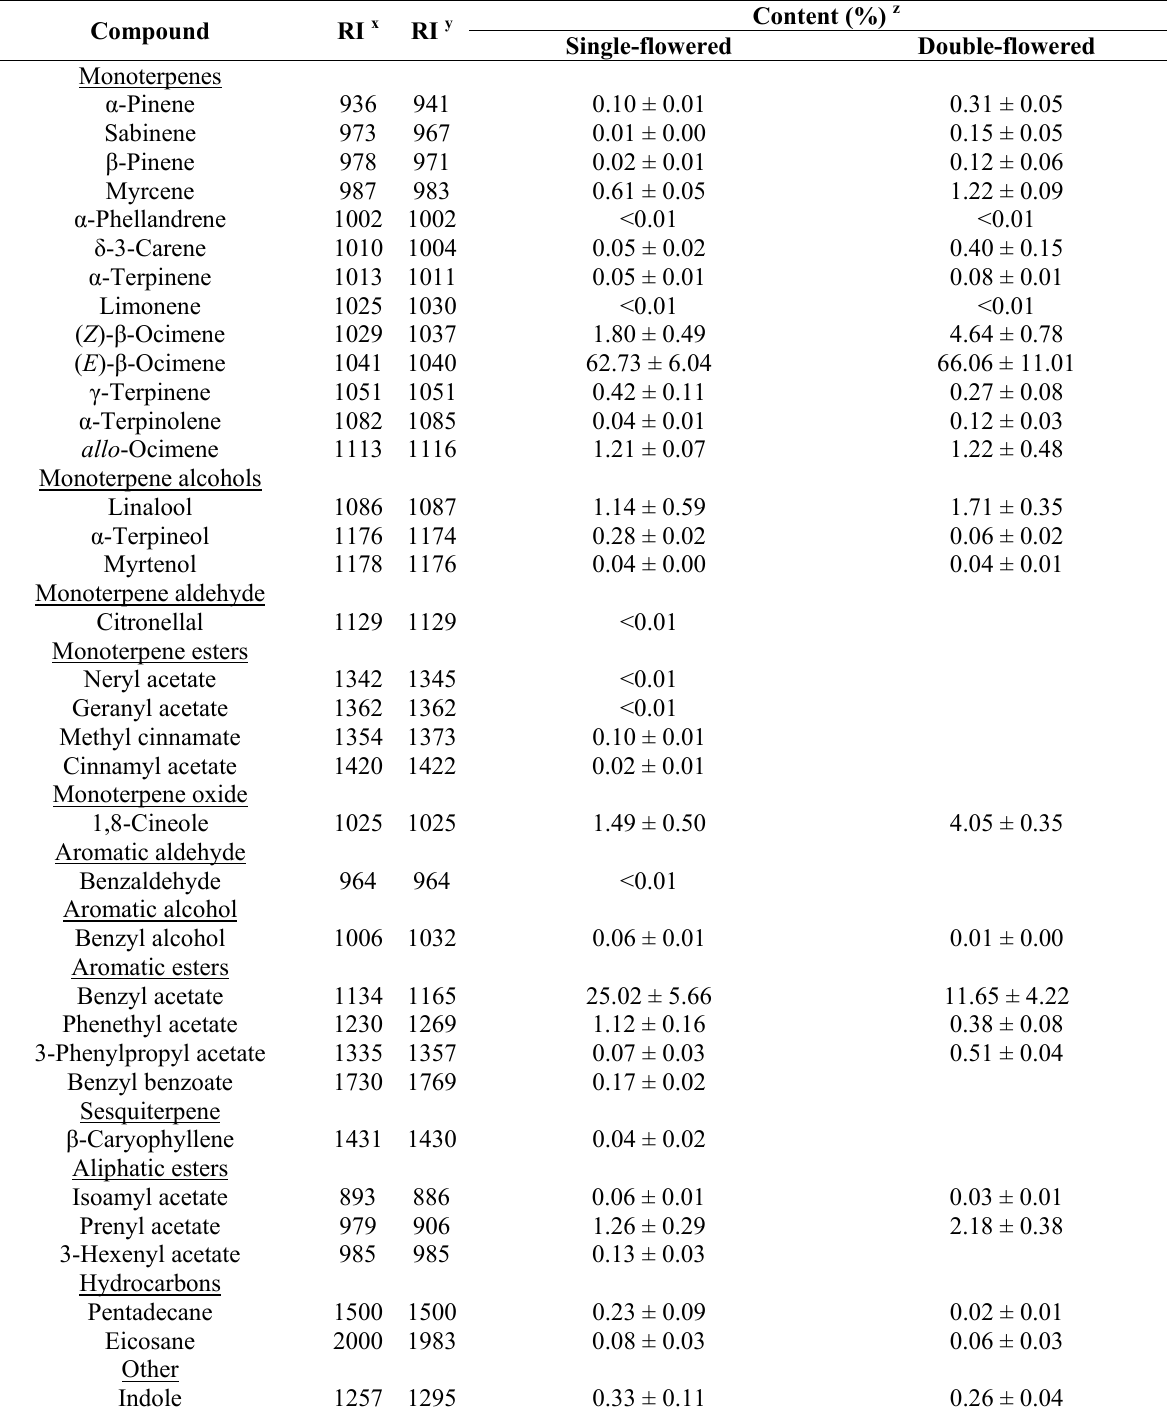
Table 2. Volatile compounds of fresh flowers of Narcissus tazetta var. chinensis